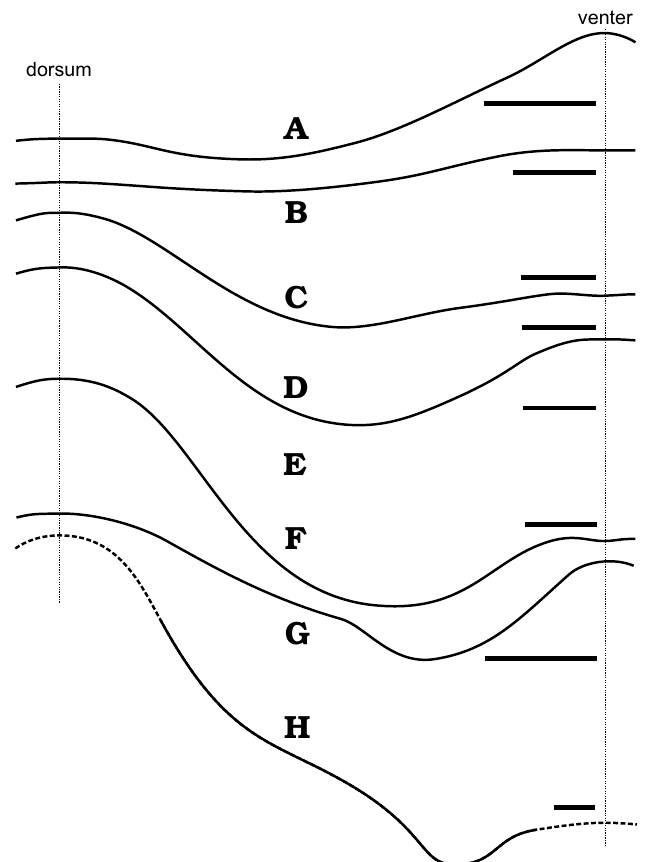
Fig. 6. Suture lines of ellesmeroceratid nautiloids from sample Ang-4, block No. 1, probably latest Furongian Ust-kut Formation found at Pashino on the Angara River, Siberia, Russia. A – H . ZPAL N. IV/109, 111, 10, 27, 56, 51, 48, and 9, respectively. Scale bars 2